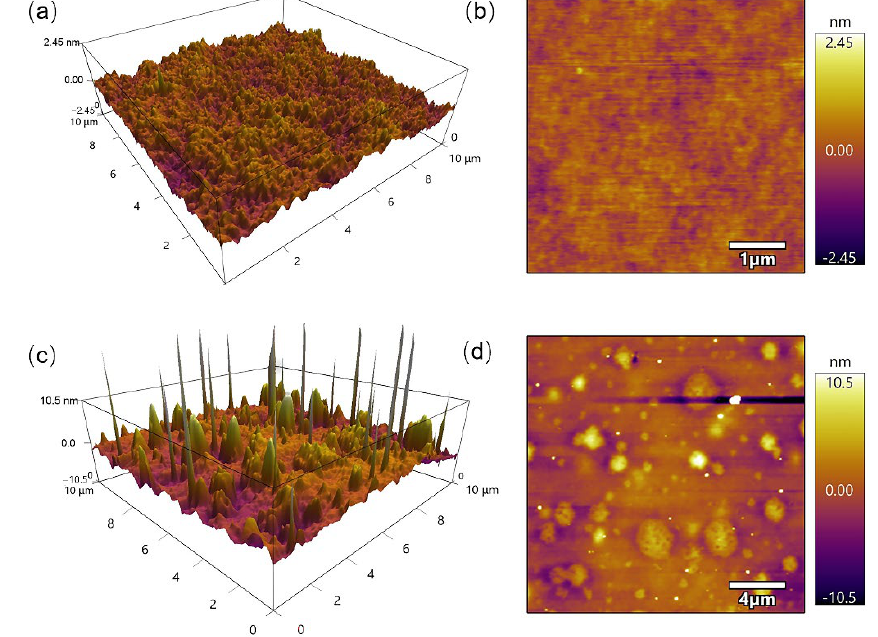
Figure 6. The AFM images of CPU and CPUSi hybrids films ( a ) and ( c ) are 3D maps of CPU0 and CPUSi20, while ( b ) and ( d ) are 2D maps of CPU0 and CPUSi20, respectively.)